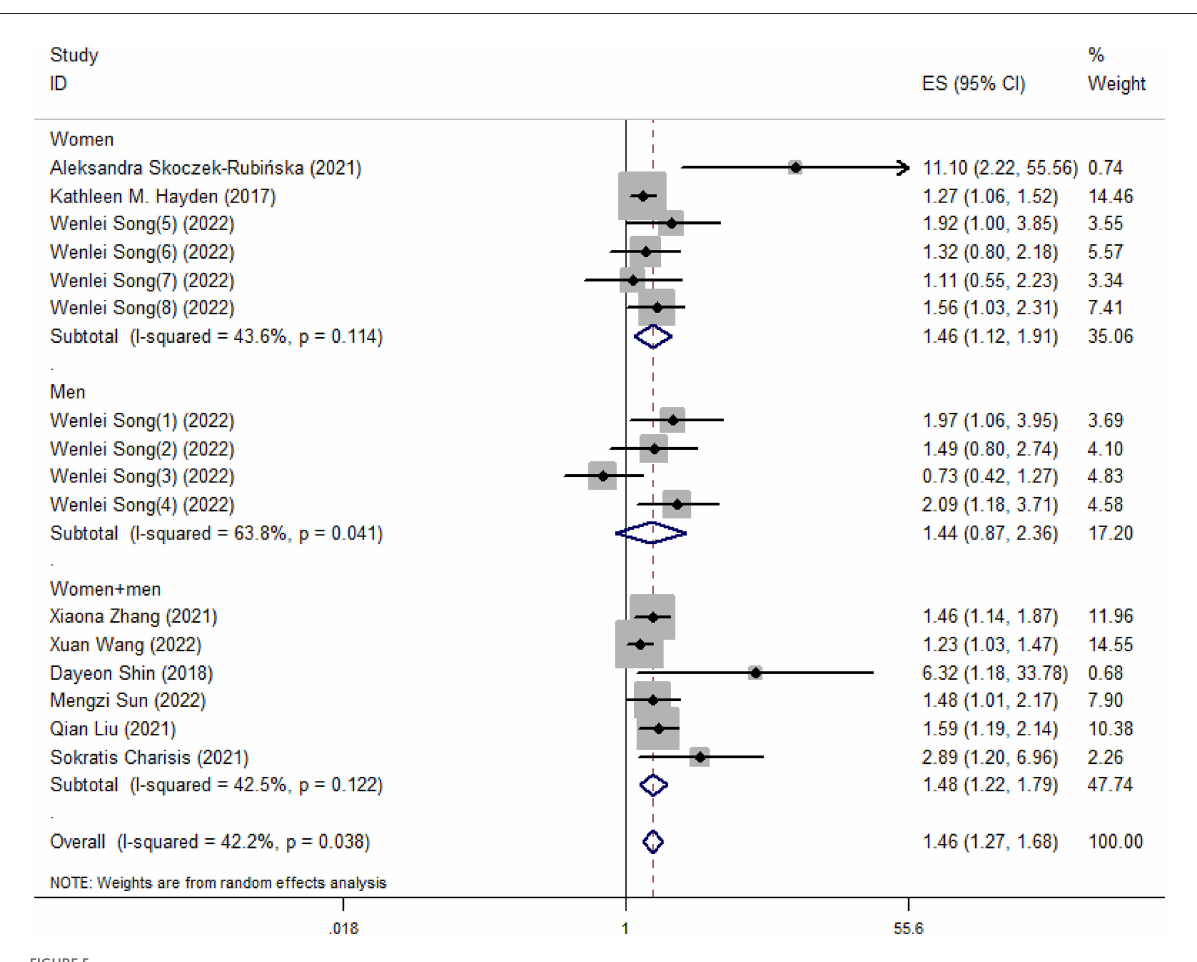
FIGURE5 Meta-analysis results of higher DII for the risk of cognitive impairment (subtotals on the basis of the gender of subjects).